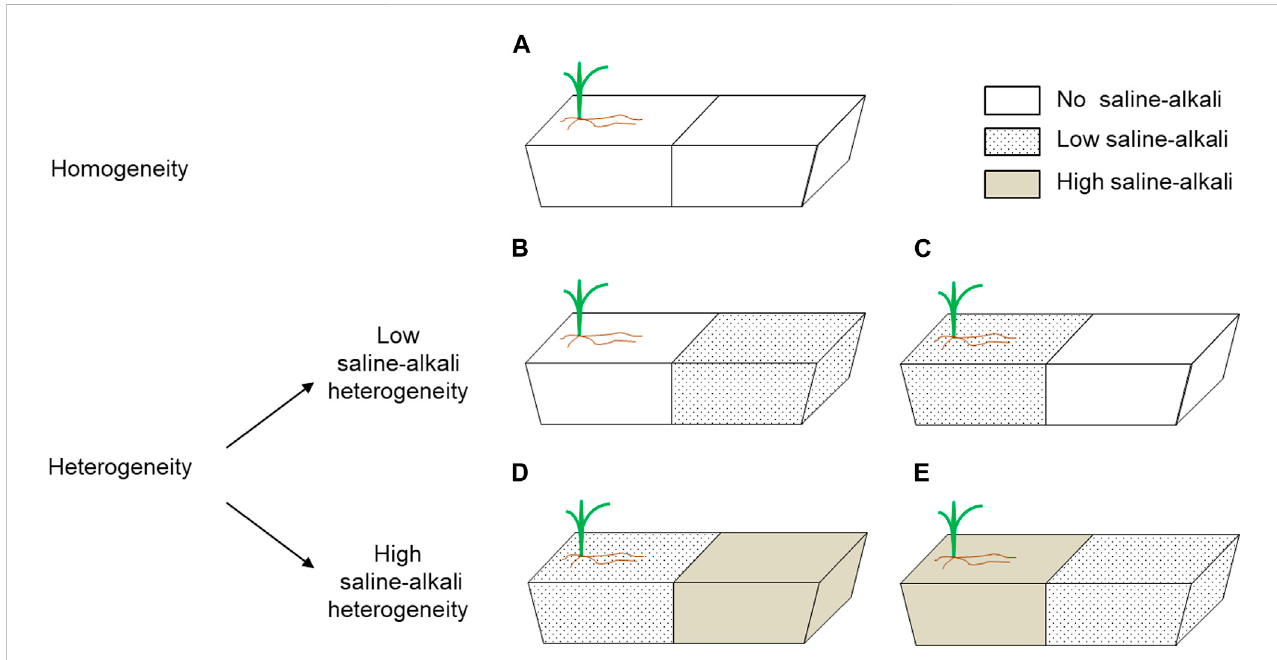
FIGURE 1 The plantingcon fi guration ofthe plants. Each long troughpot has one plant, which isplanted on theside ofthe pot.Schematicrepresentation ofsaline- alkali stress treatments given to different patches. (A) homogeneous patches without saline-alkali conditions in either part of the pot (homogeneity); (B,C) no saline-alkali conditions and low saline-alkali conditions in the same pot, separated by the inserted board (low saline-alkali heterogeneity); (D,E) low and high saline-alkali conditions in the same pot, separated by the inserted board (high saline-alkali